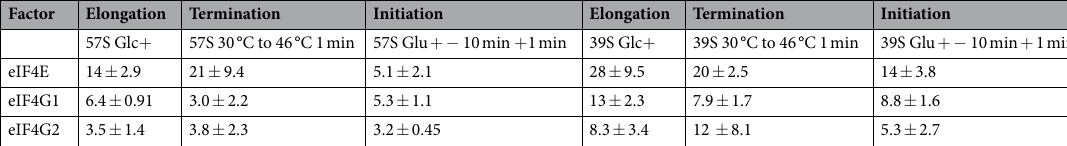
Table 3. Stocihiometric analysis of translation factors in 57S complex under different translation conditions following PAB1-Flag pull downs. Stoichiometric analyses were conducted under the conditions indicated as described in Table